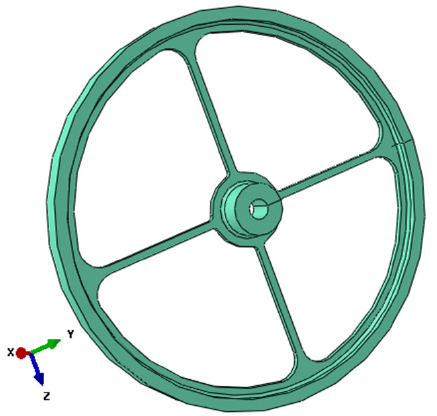
Figure 9. Optimal shape features of the flywheel.